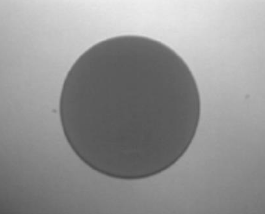
Figure 12. Magnified image of a levitated molten metal sample whose diameter is around 1.6 mm.